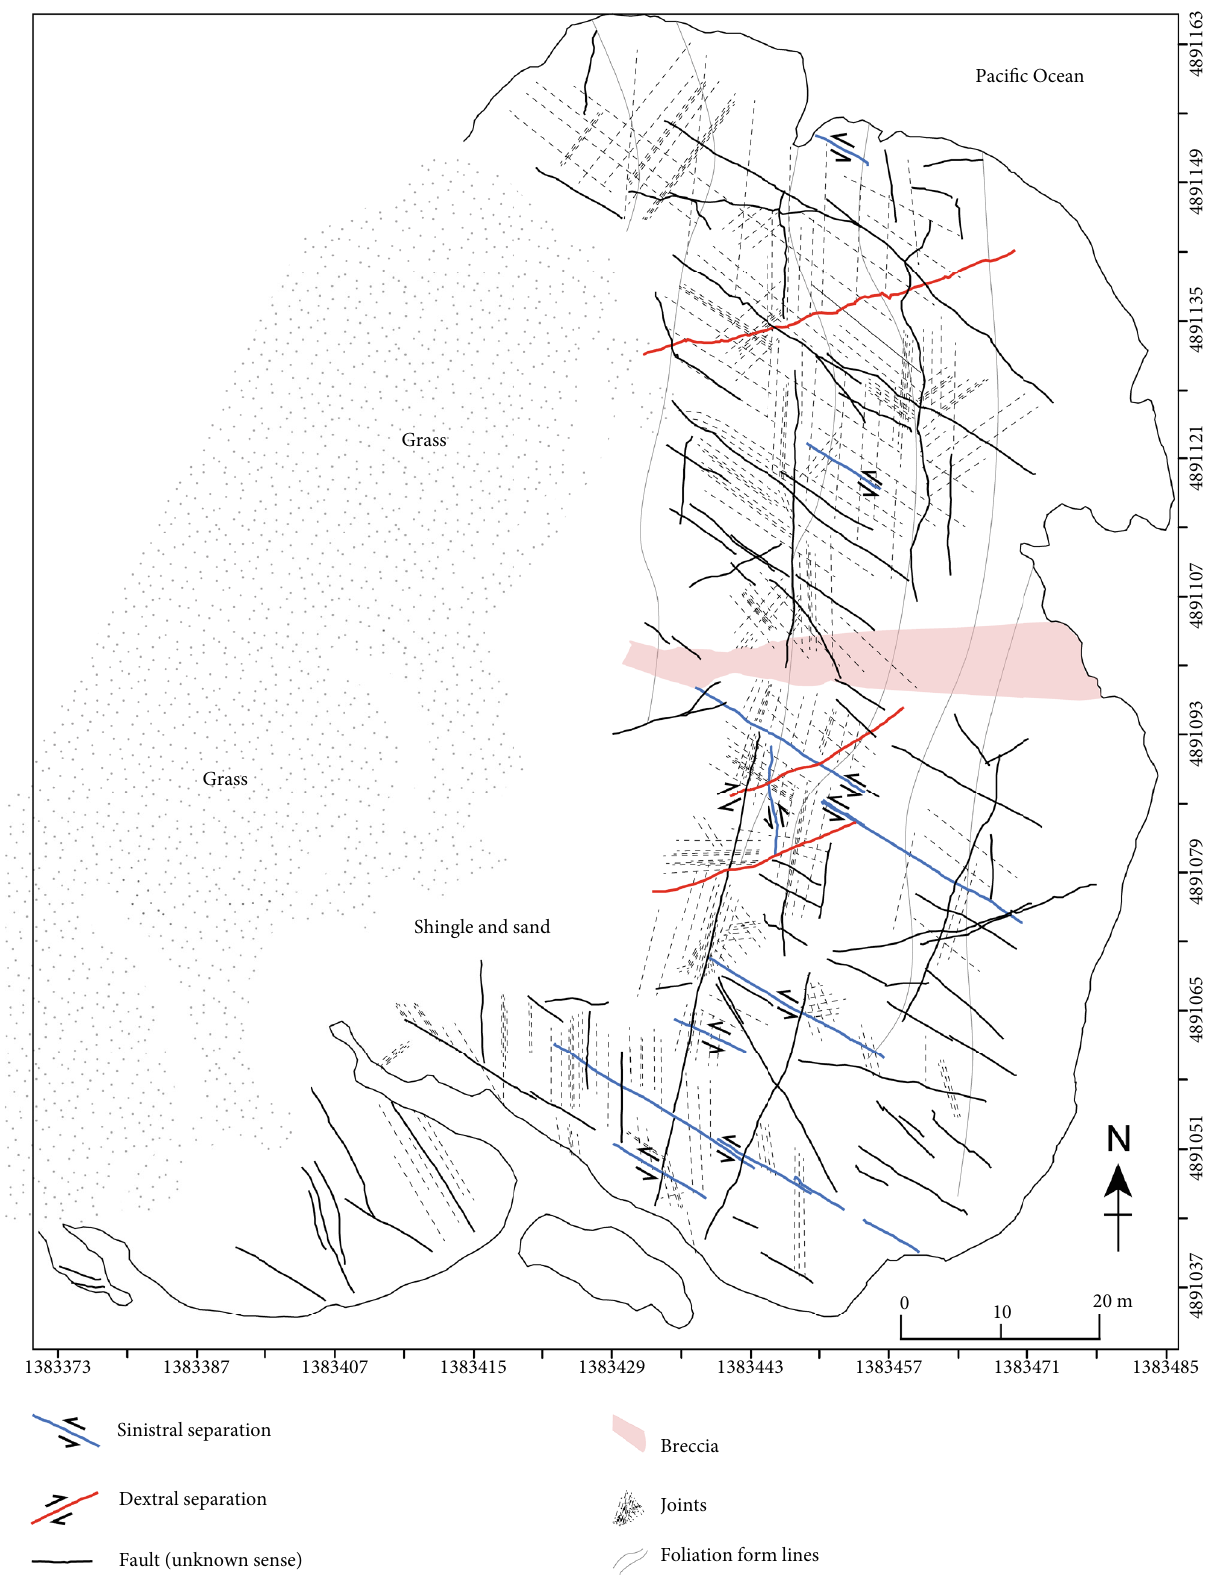
Figure 3: Detailed geological map of a coastal exposure approximately 2 km to the north of Akatore Creek. Grid references are NZTM. The map highlights the distribution and orientation of the metamorphic foliation, exhumation joints, and small-displacement strike-slip